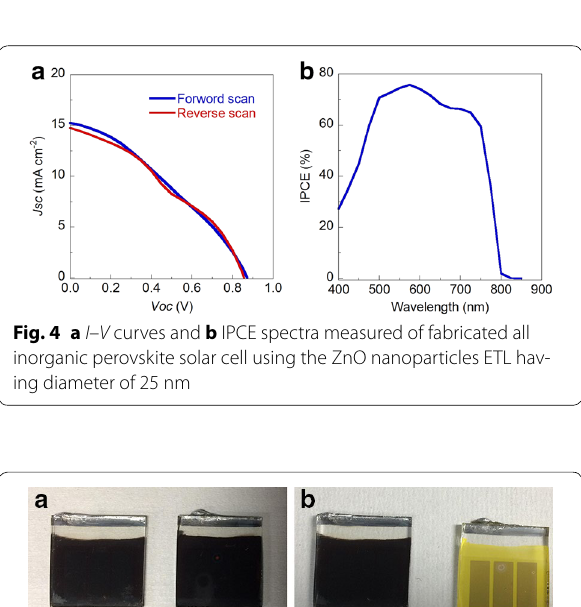
V OC and reverse: V OC →